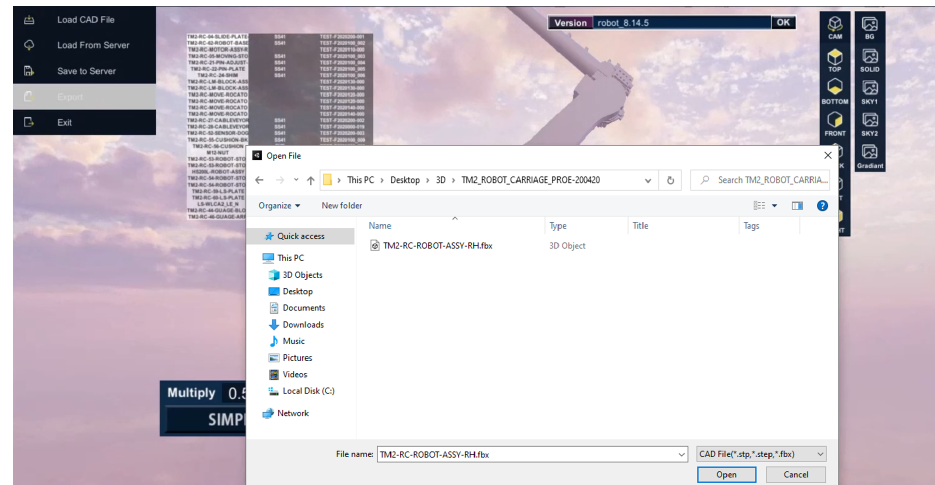
Figure 14. FBX model file capacity optimization.